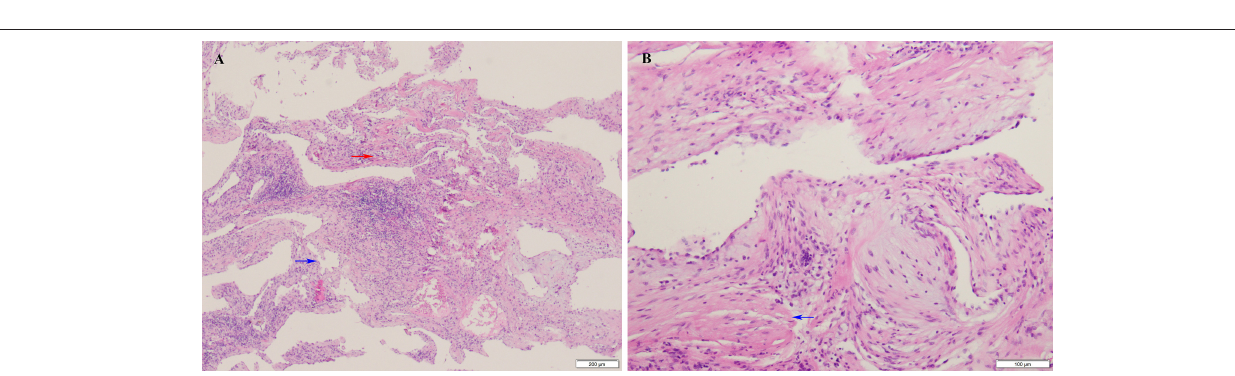
FIGURE 4 | (A) Histopathology revealed that there are a lot of branches of vessels, thick-walled arteries (red arrow) and thin-walled veins (blue arrow), which was identified as cardiac arteriovenous malformation. (B) Histopathology showed the anomalous arteries with thick wall are composed of smooth muscle (blue